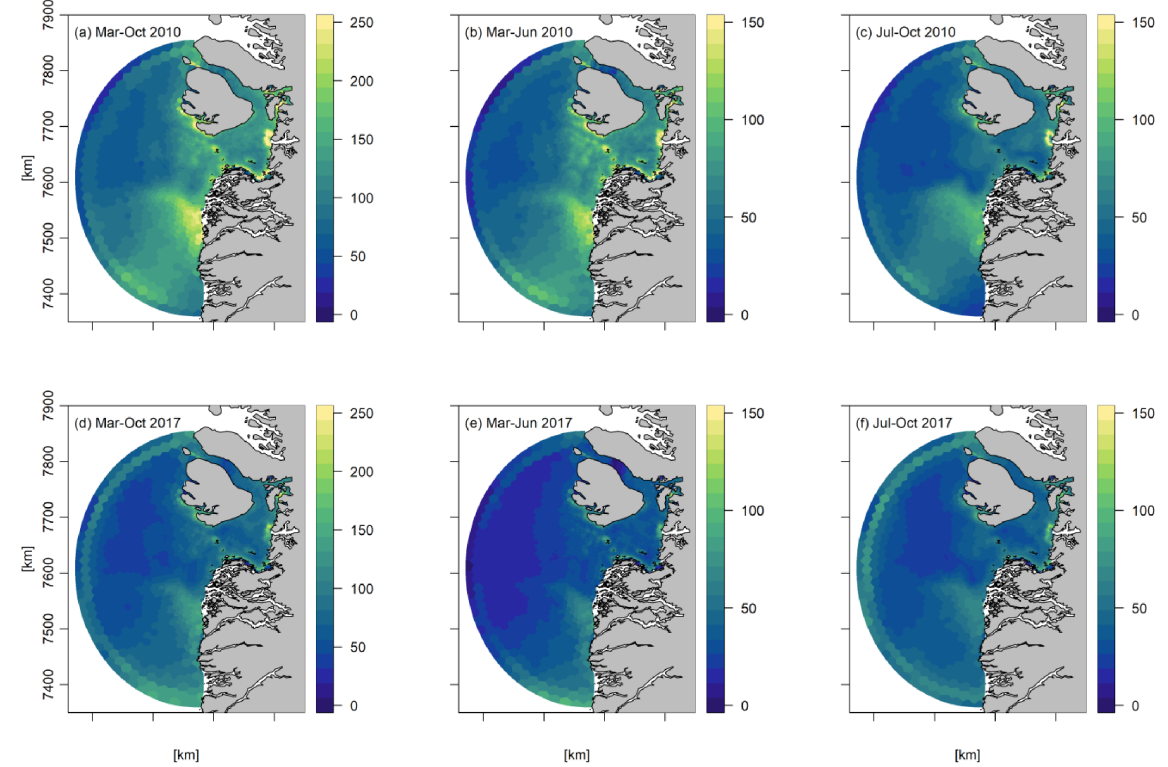
Figure 6. Average spatial distribution of primary production (gCm − 2 ) in 2010 and 2017 for the periods (a, d) March–October, (b, e) March–June, and (c, f)